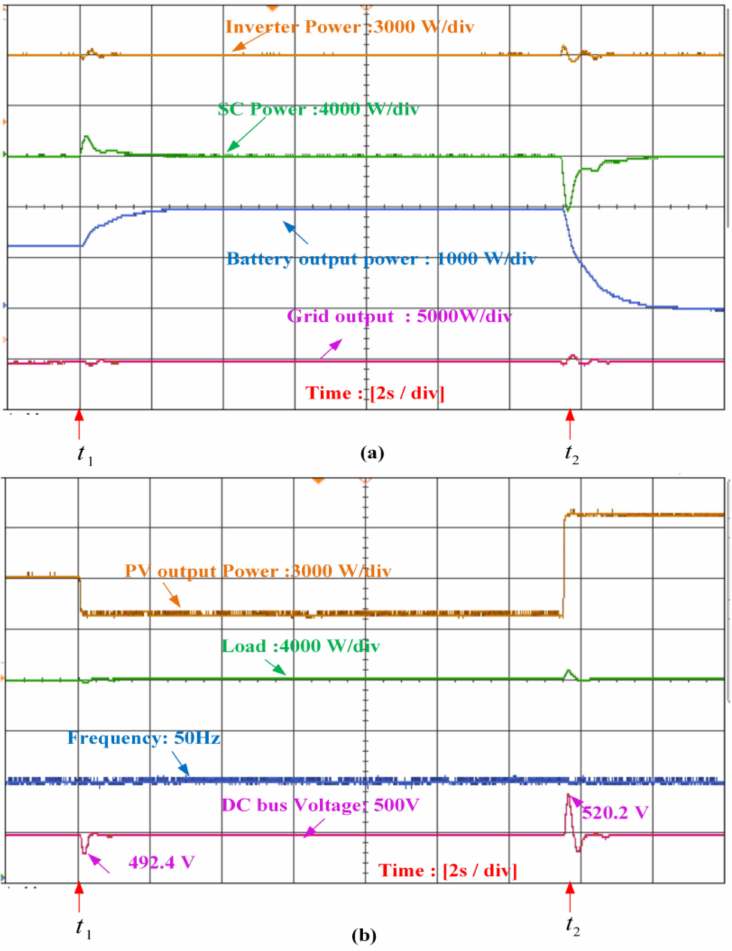
Figure 18. Under irradiation change at base load ( a ) power from the inverter, SC, battery, and grid; ( b ) PV power, load, frequency, and DC bus